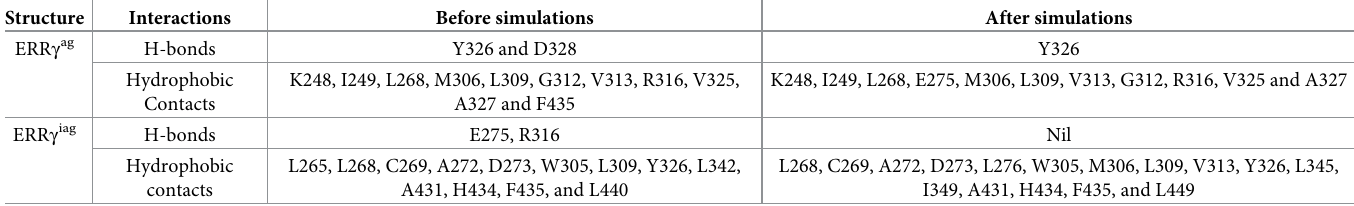
Table 2. Comparison of interaction between the ligands and ERR γ structure.